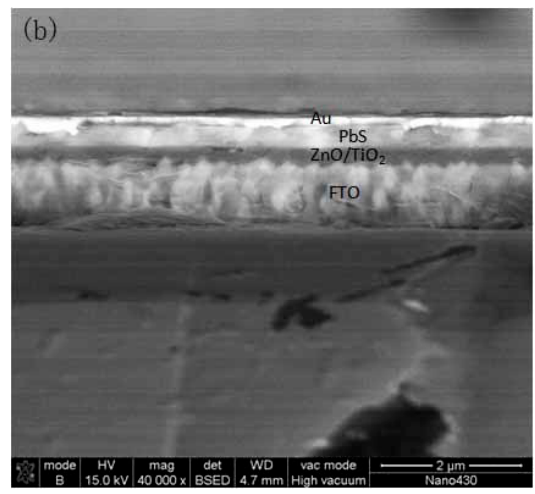
Figure 2. ( a ) Schematic of FTO/ZnO/TiO 2 /PbS/Au device architecture ( b ) The cross-sectional SEM images of a representative device.